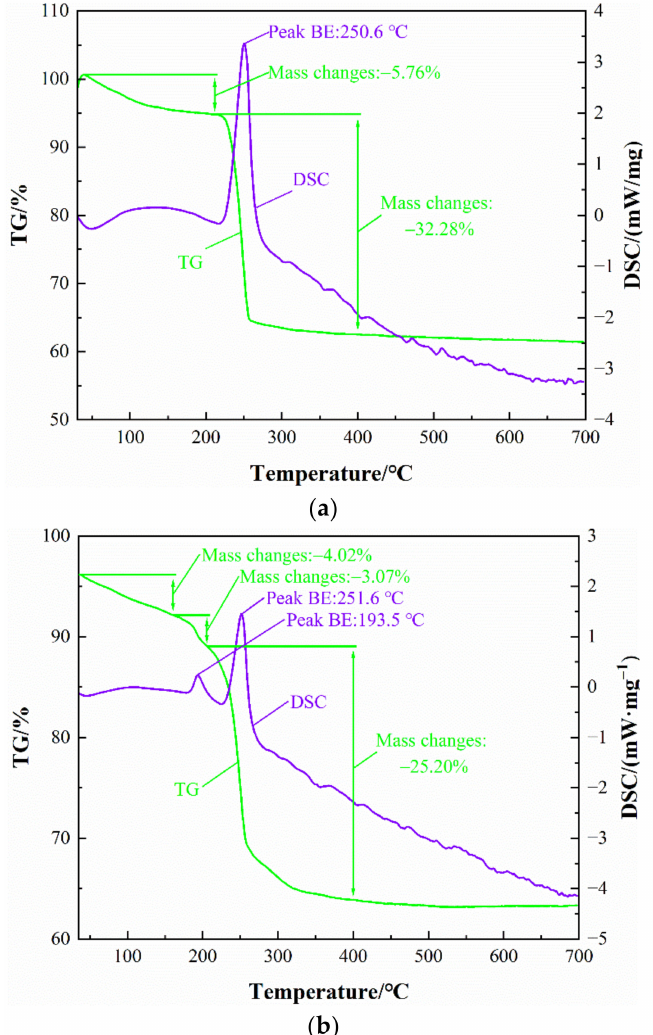
Figure 6. TG and DSC curves of the precursor powders: ( a ) pure copper precursor powder; ( b ) Cu-20 wt%W precursor